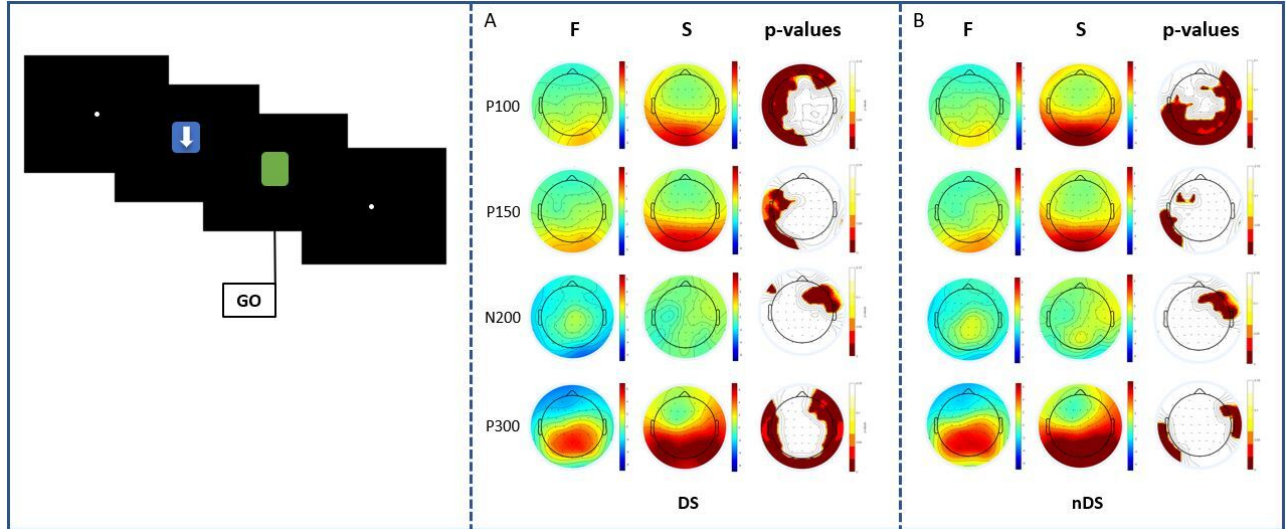
Figure 5. Mean scalp distribution of potentials in faster (F) and slower (S) groups and maps of statistical di ff erences ( p ‐ value distribution) between F and S in the go stimulus of DS ( A ) and nDS ( B ) conditions for P100, P150, N200 and P300 latencies. Table 2. Signi fi cant values ( p < 0.05) related to all electrodes for P100, P150, N200 and P300 for the go stimulus in the directional (DS) condition between the fast (F) and slow (S) groups; “ ‐ “ indicates non ‐ signi fi cant results. The results were corrected using the FDR method to resolve the issue of multiple comparisons.